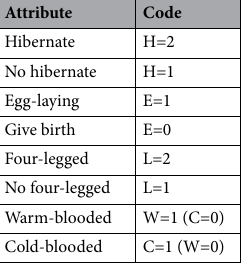
Table 2. Attributes and their